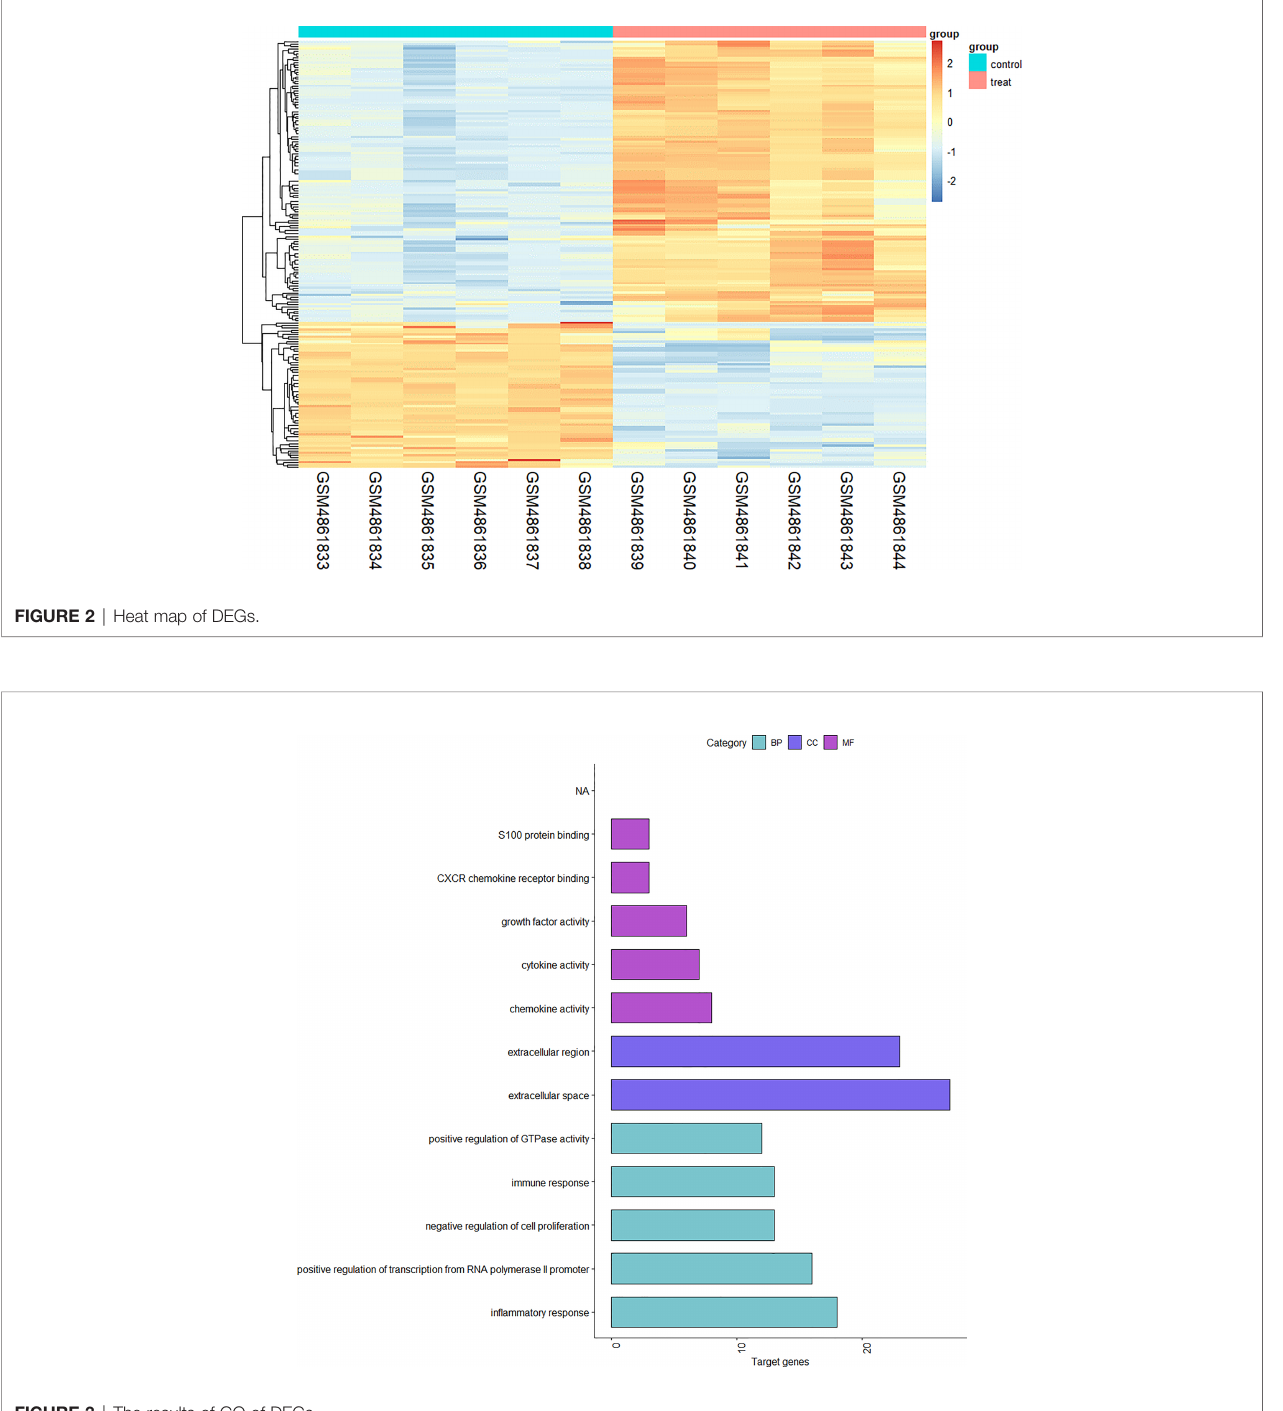
FIGURE 3 | The results of GO of DEGs.